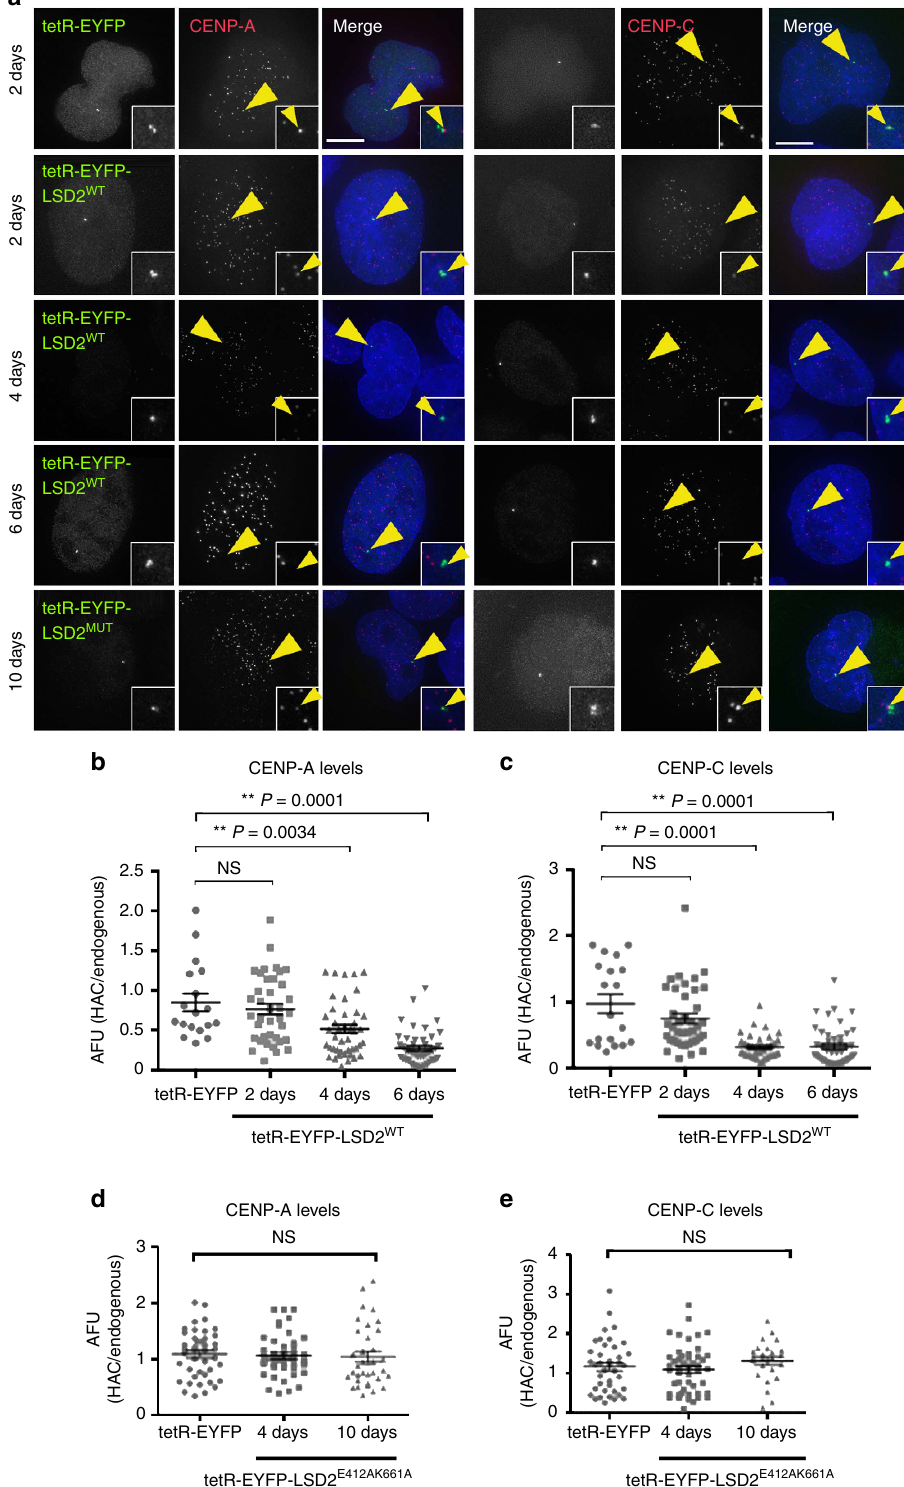
Figure 3 | Tethering LSD2 to the alphoid tetO HAC centromere affects the kinetochore assembly. ( a ) Immunofluorescence analysis of 1C7 cells expressing the indicated tetR-EYFP fusion proteins at the indicated time points and stained for either CENP-A (left) or CENP-C (right). Arrowheads depict the HAC. Scale bar, 10 m m. ( b – e ) Fluorescence signals of HAC-associated CENP-A ( b , d ) and CENP-C ( c , e ) staining in individual cells transfected with the indicated tetR-fusion constructs were quantified and plotted as AFU. Solid bars indicate the medians and error bars represent the s.e.m. N ¼ two independent experiments for each time point and staining. Asterisks indicate a significant difference (* P o 0.05; ** P o 0.01; Mann–Whitney’s